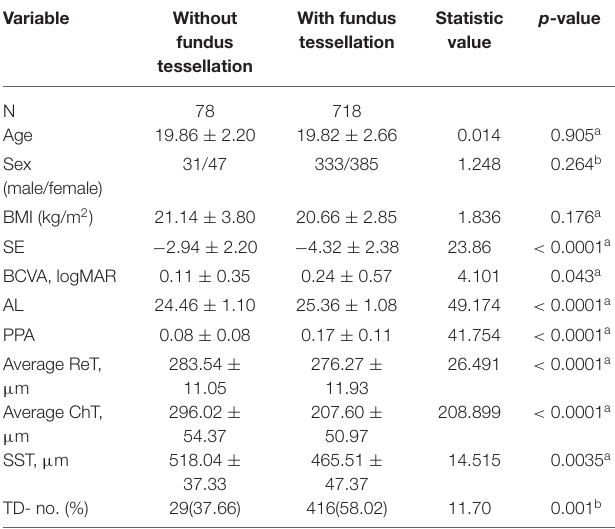
( Figure 2 ). The data of ChT in each subregion of each grade 4 ), where the value of ChT was shown in different color, with color red being the thickest to color blue the thinnest. As shown